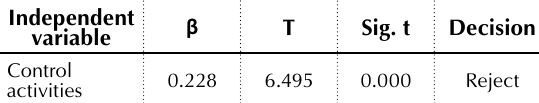
Table 6. Results of a simple linear regression analysis to test the fifth sub-hypothesis ( H05 )